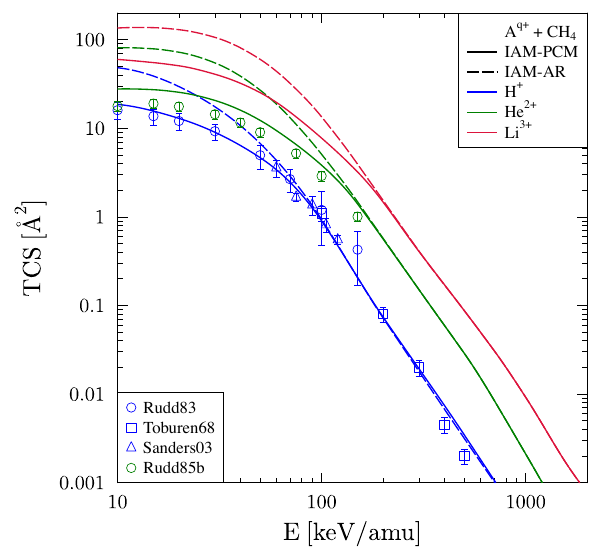
Figure 5. Net electron capture cross section for collisions of protons, He 2 + , and Li 3 + ions with methane (CH 4 ). The dashed curves show the IAM-AR results, while the solid curves are obtained with the IAM-PCM. The curves merge at lower energies for proton impact (shown in blue), followed by He 2 + impact (shown in green), and even higher energies for Li 3 + projectiles (shown in red). The experimental data are from References